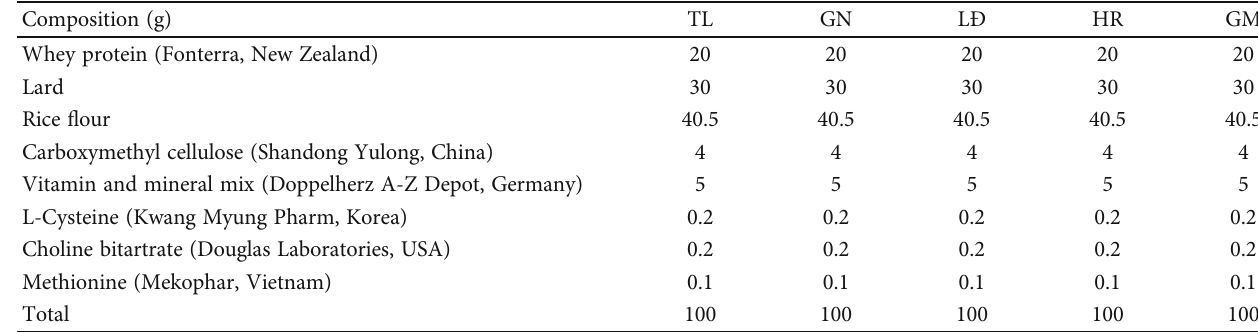
Table 1: Composition of high-fat diets (HFD) 1 .